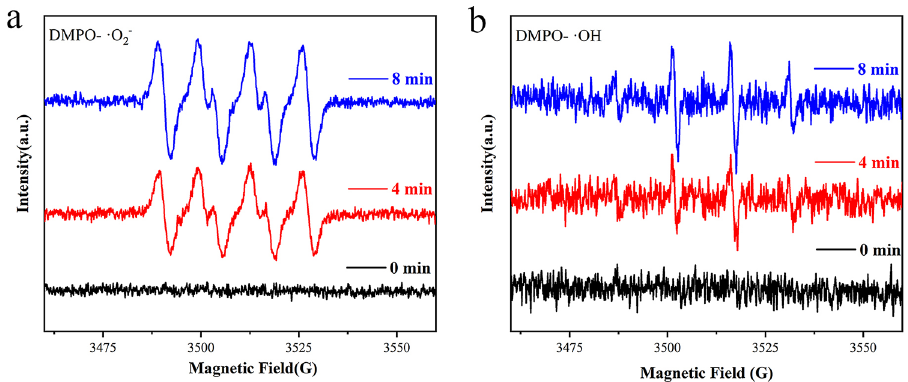
Figure 7. EPR spectra of ACA-2 for detecting ( a ) DMPO · O 2− and ( b ) DMPO · OH under the visible light irradiation.